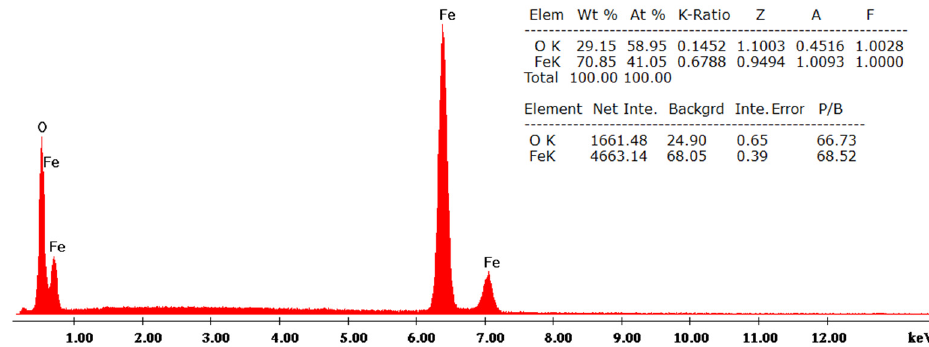
Figure 2. EDX spectrum of the magnetite powder.